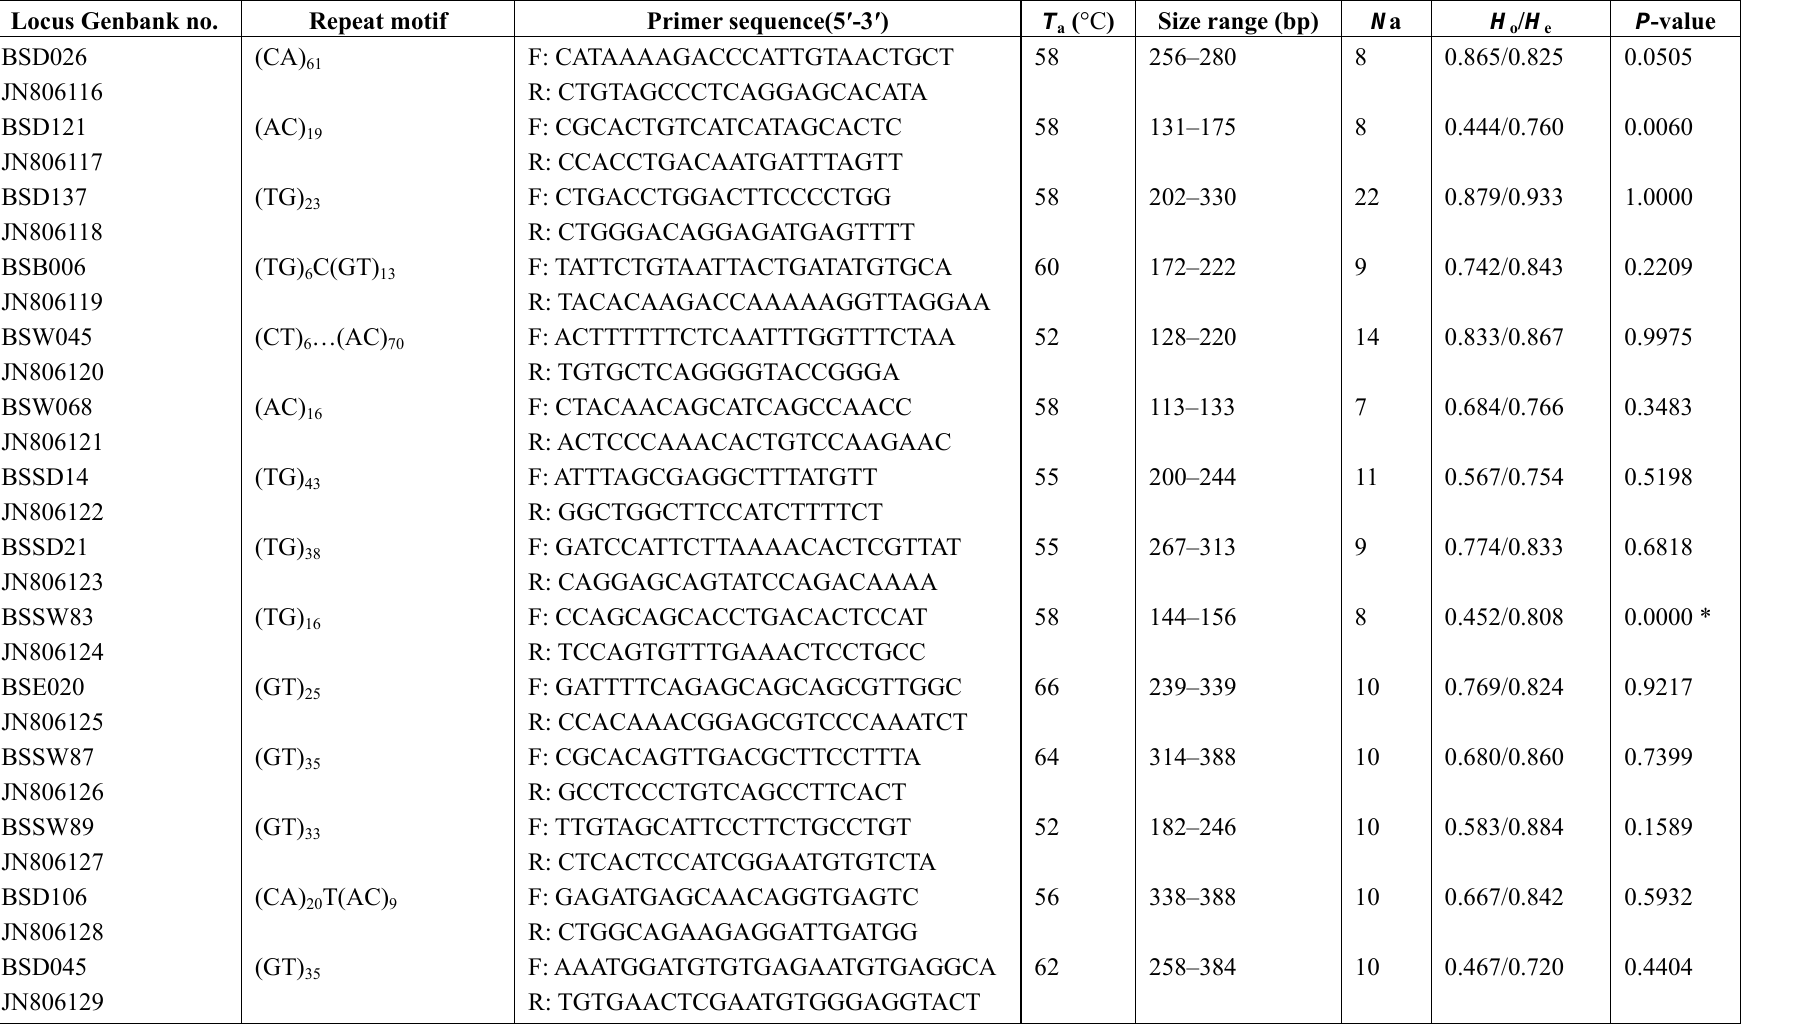
Table 1. Details for 20 polymorphic microsatellite loci developed for Bostrychus sinensis . Locus Genbank